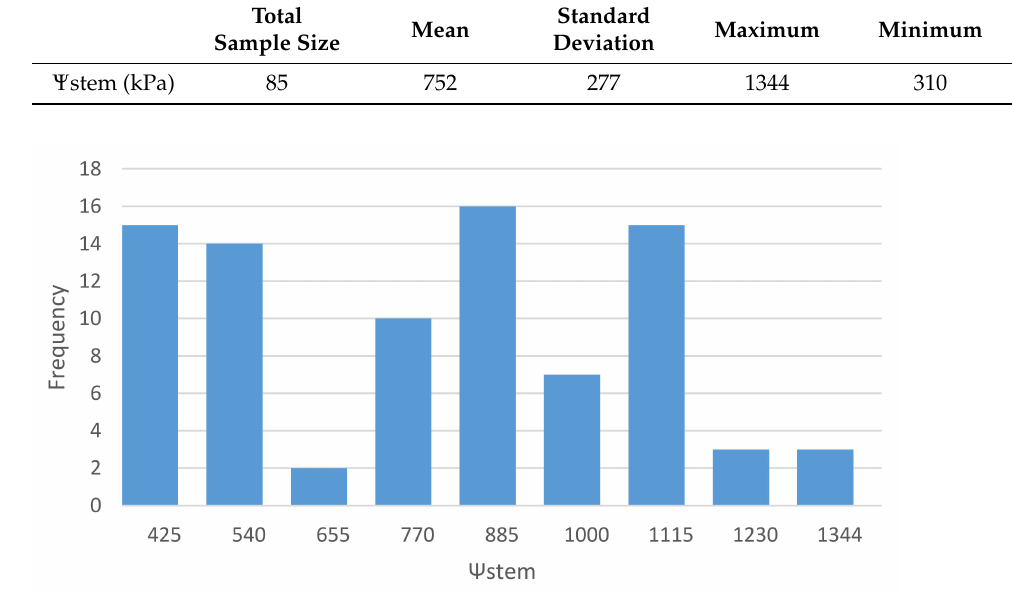
Figure 5. Distribution of Ψ stem (kPa) for all the samples (n = 85). The dataset is not normally